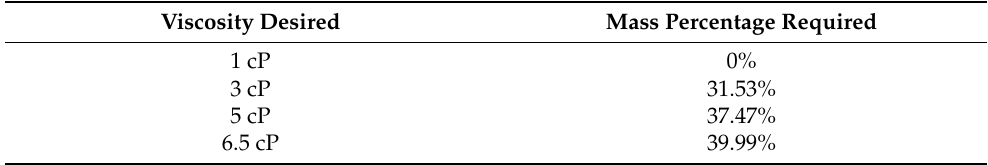
Table 2. Determined Mass